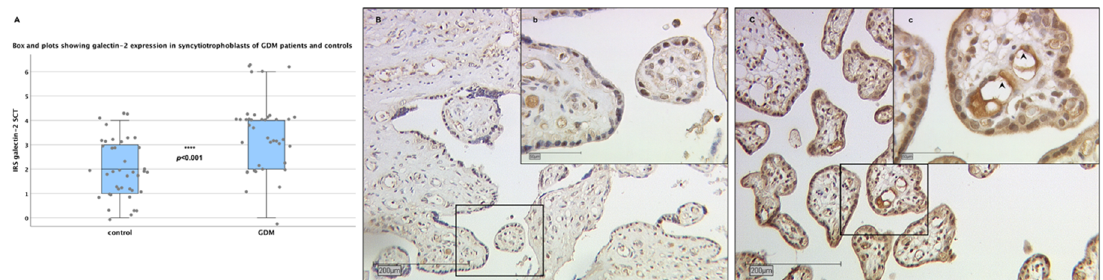
Figure 2. Galectin-2 expression in syncytiotrophoblast (SCT) of control and gestational diabetes mellitus (GDM) placentas. Box and scatter plots ( A ) showing the IRS for galectin-2 expression in SCT to be significantly higher in GDM placentas ( p < 0.001). See Figure 1 for a detailed plot explanation. Pictures show representative slides for immunohistochemical staining of galectin-2 in the SCT of the control ( B ) and GDM ( C ) placentas. The scale bar equals 200 µ m in full size images and 50 µ m in inserts. Black rectangles indicate the section seen at higher magnification (minuscular letters). Arrow heads show strongly stained fetal endothelial cells.